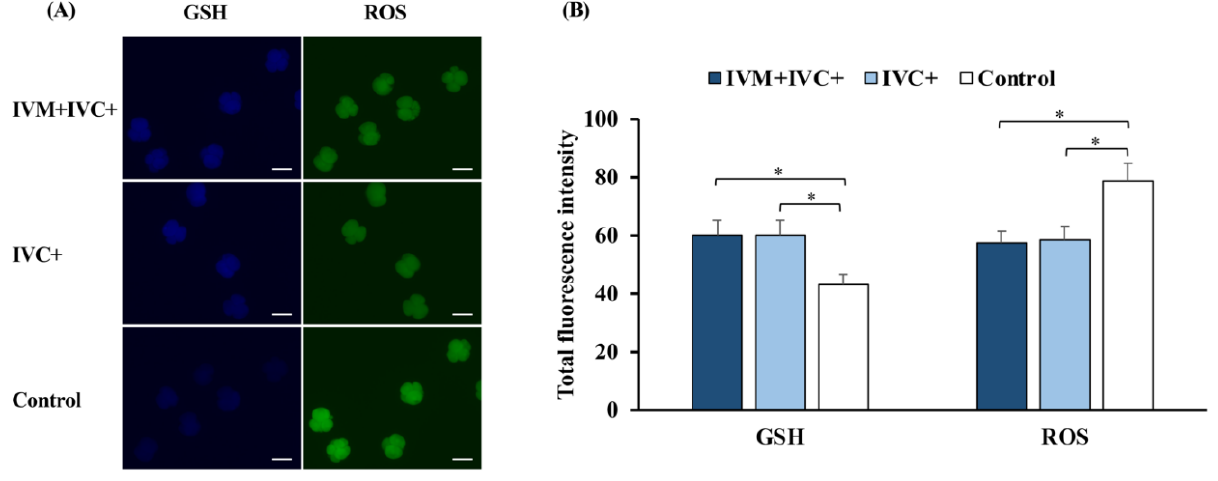
Figure 5. Effects of melatonin on intracellular glutathione (GSH) and reactive oxygen species (ROS) levels in in vitro-produced 4-cell embryos at 48 h of culture. ( A ) Representative images of embryos stained with CellTracker Blue (GSH) or with 2′ , 7′ -dichlorodihydrofluorescein diacetate (ROS). Scale bar: 100 µm. ( B ) Effects of melatonin on GSH and ROS levels in embryos. Melatonin (1 nM) was added to both the maturation and culture media (IVM + IVC+ group; n = 28) or only to the culture medium (IVC+ group; n = 32). Oocytes that were matured, fertilized, and cultured in media without melatonin supplementation were used as controls ( n = 30). * p < 0.03. Data are presented as the means ± SEM (three replicates).